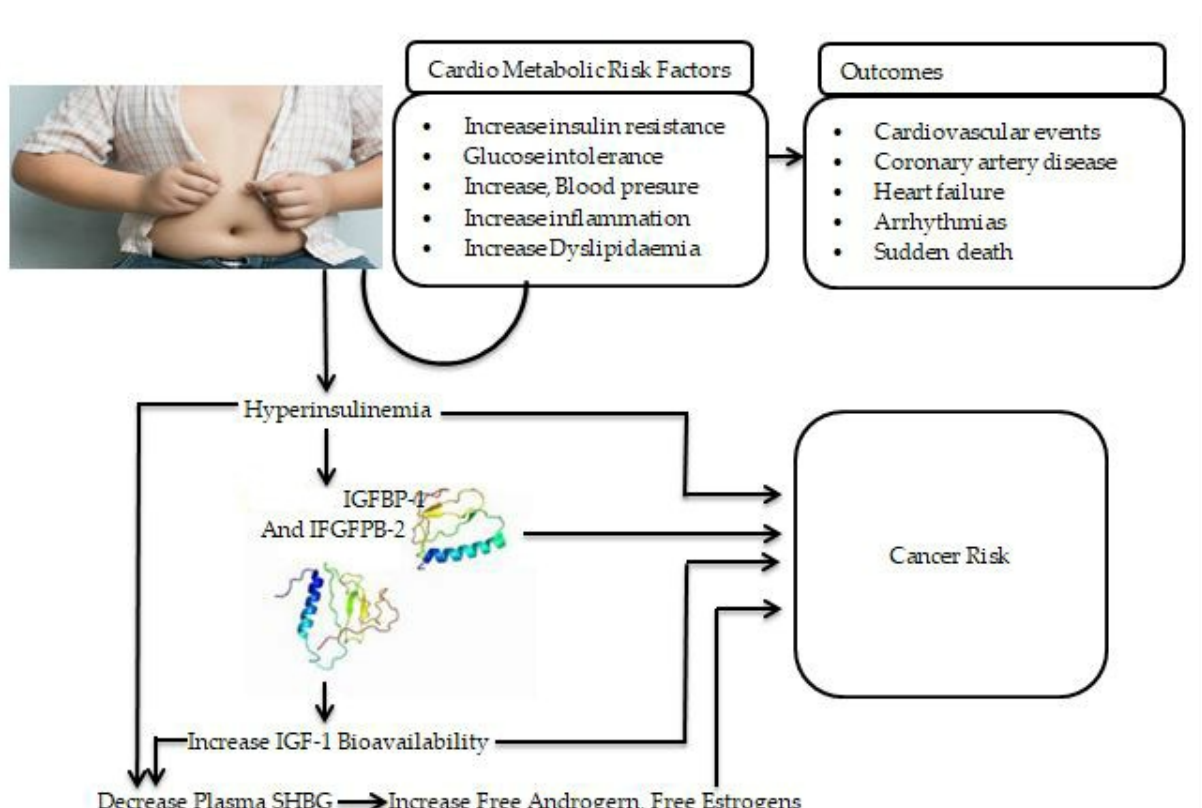
Figure 2. The link between obesity and other chronic non-communicable diseases and proposed mechanisms of obesity and increased cancer risk. IGF-1: insulin-like growth factor-1; IGFBP-2: insulin-like growth factor binding protein-2; IGF-1: insulin-like growth factor -1; SHBG: sex hormone-binding globulin.